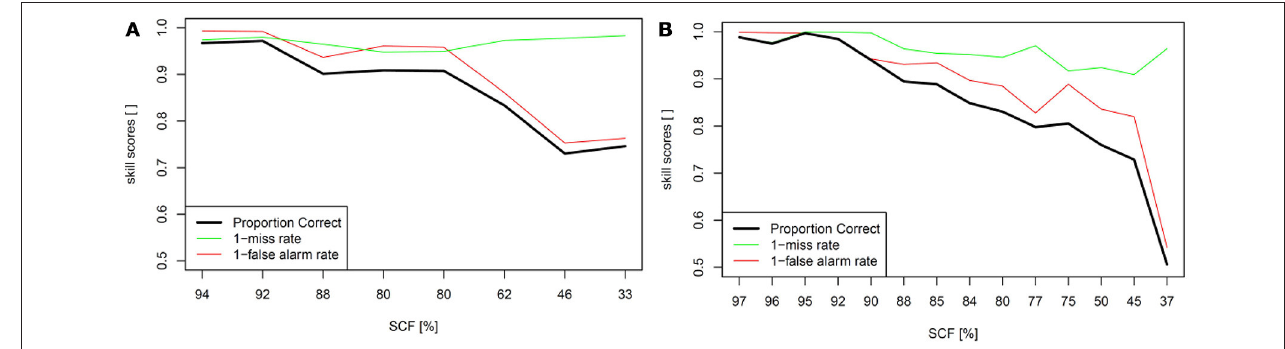
FIGURE 6 | Skill score for 2014 (A) and 2015 (B) as a function of different snow cover fractions (SCF) for the Gletschboden area. Correctly forecasted pixels (black) and the error due to misses (green) and false alarm (red) are